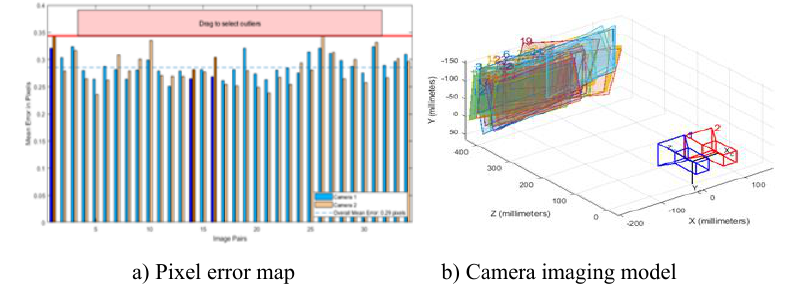
Fig. 2. Matlab camera calibration results.